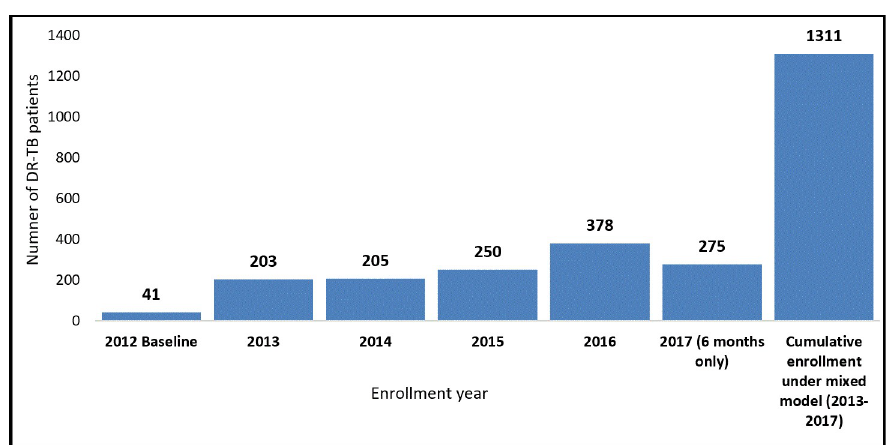
Fig 1. The number of RR-TB/MDR-TB patients enrolled by year.